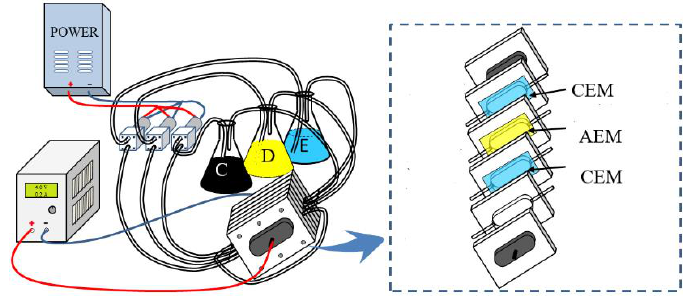
Figure 1. ED setup for soy sauce desalination. D — diluate vessel, C — concentrate vessel, E — elec- rinsing solution vessel, CEM—cation exchange membrane, AEM—anion exchange trode rinsing solution vessel, CEM — cation exchange membrane, AEM — anion exchange mem- brane.